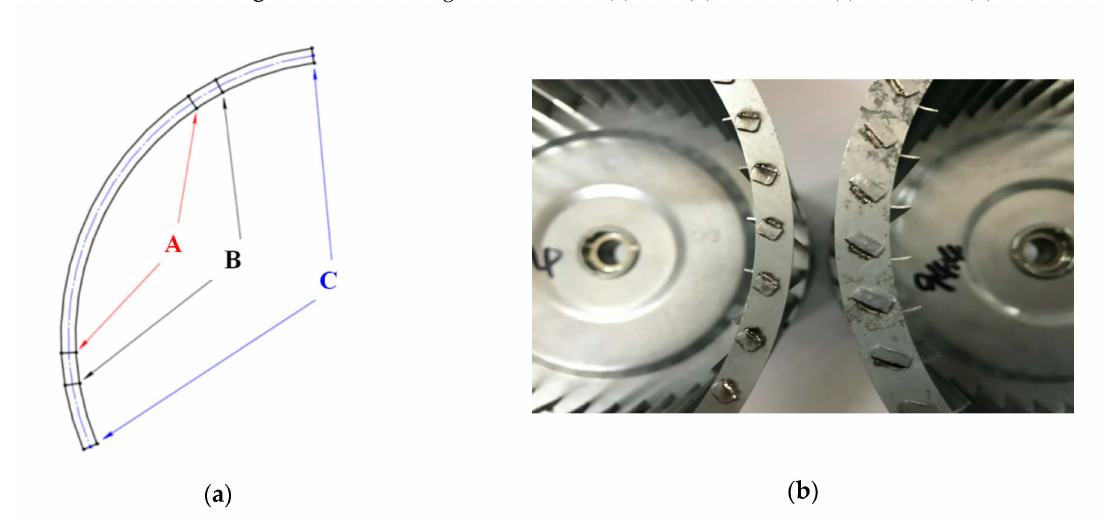
Figure 2. Blades. ( a ) Three blades with different lengths, ( b ) A blade and B